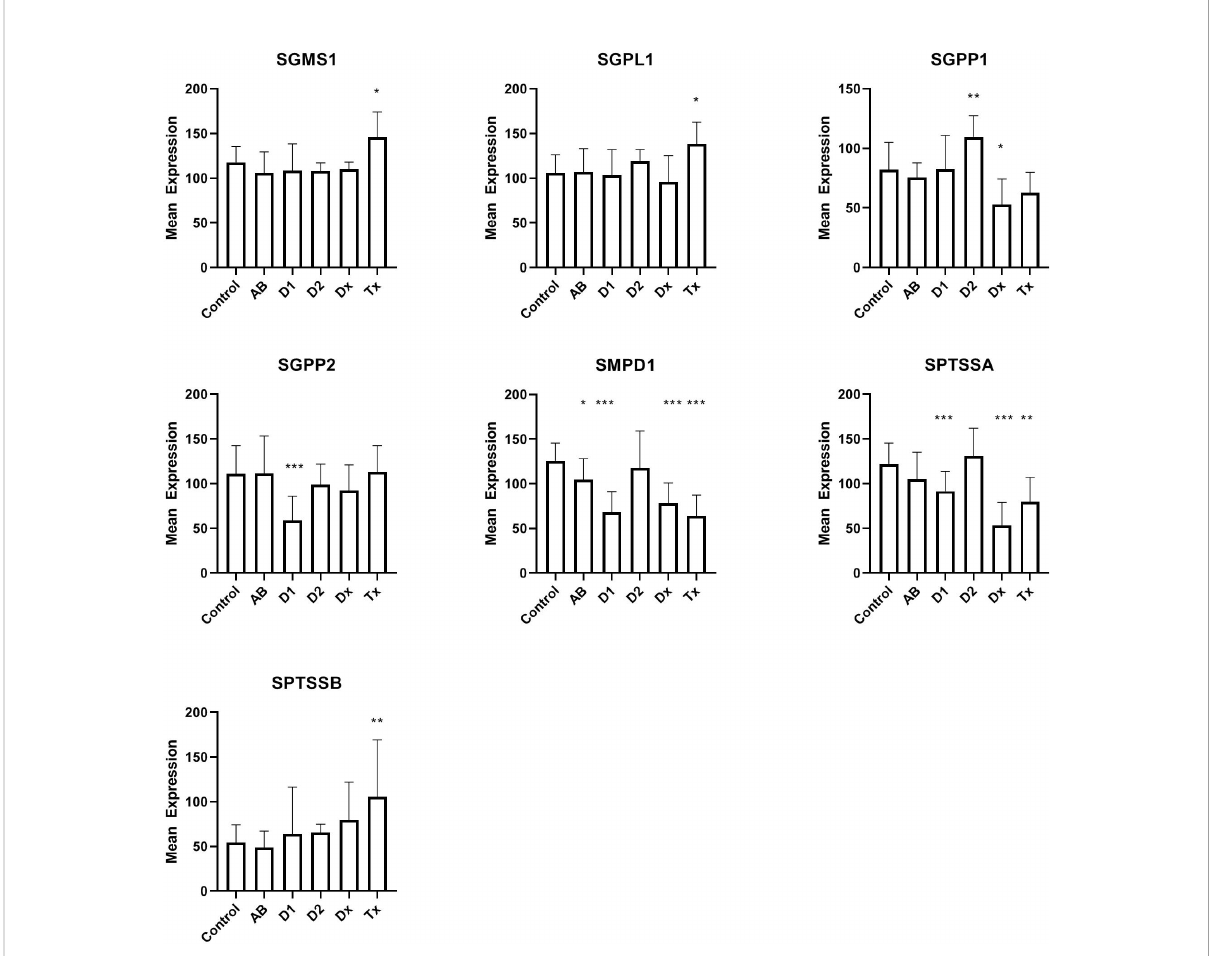
FIGURE 1 Expression levels of islet of Langerhans mRNA from genes related to synthesis or degradation of ceramide or sphingomyelin. For comparison between groups, one-way ANOVA was used with Dunnett ’ s multiple comparison test and a 95% CI. C: non-diabetic control patients, AB: non- diabetic subjects with auto-antibodies, D1, Type 1 diabetes of longer duration; D2, Type 2 diabetes; Dx, Newly diagnosed Type 1 DiViD samples; Tx, Biopsies from pancreatic transplants with recurrent diabetes. *p<0.05, **p<0.01,